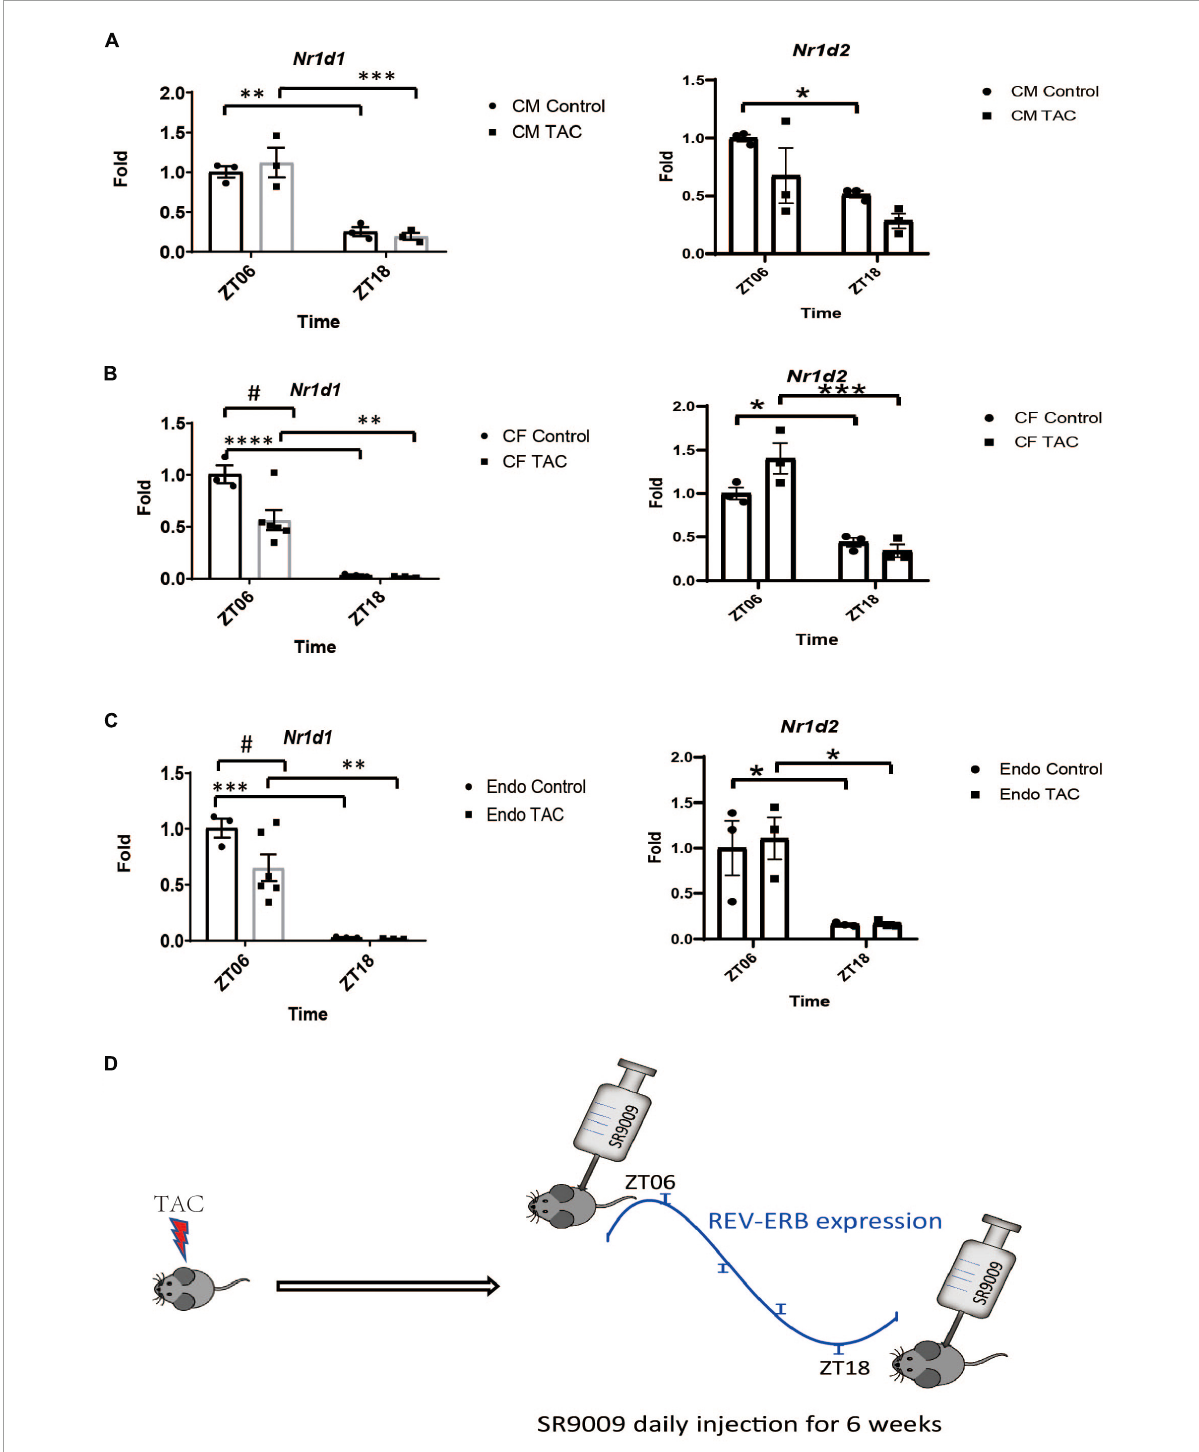
FIGURE3 The rhythmic expression of REV-ERB in the major cell types of the heart. (A–C) Relative mRNA expression levels of Nr1d1 and Nr1d2 in major cell types in the heart (CM-cardiomyocytes, CF-cardiac fibroblasts and Endo-endothelial cells) isolated from mouse hearts at 6 weeks after TAC or sham surgery at ZT6 or ZT18. # p < 0.05, ∗ P < 0.05, ∗∗ p < 0.01, ∗∗∗ P < 0.001 by two-way ANOVA. Tukey’s test was used for multiple comparison corrections. n = 3. (D) Diagram of the SR9009 treatment schemes. Mice receive daily SR9009 injection post-TAC at ZT06 or ZT18 for 6 weeks. **** P <